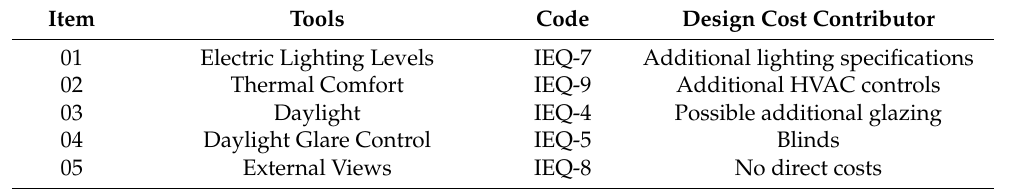
Table 11. Credit summary for